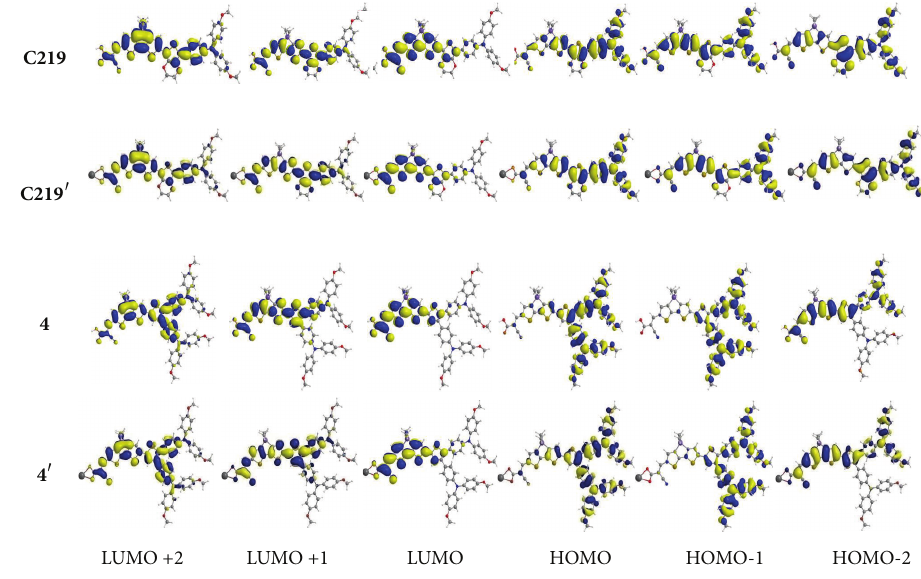
Figure 2: The frontier molecular orbitals of sensitizers C219 , C219 󸀠 , 4 , and 4 󸀠 . Isodensity contour = 0.02.